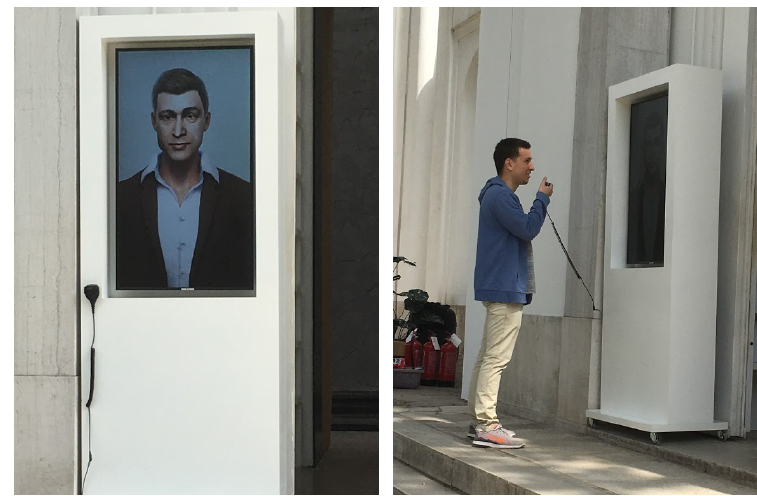
Figure 6. To the left of this figure is the final installation for the system inspired by Paul Celan. To the right one of us is demonstrating how to talk to the